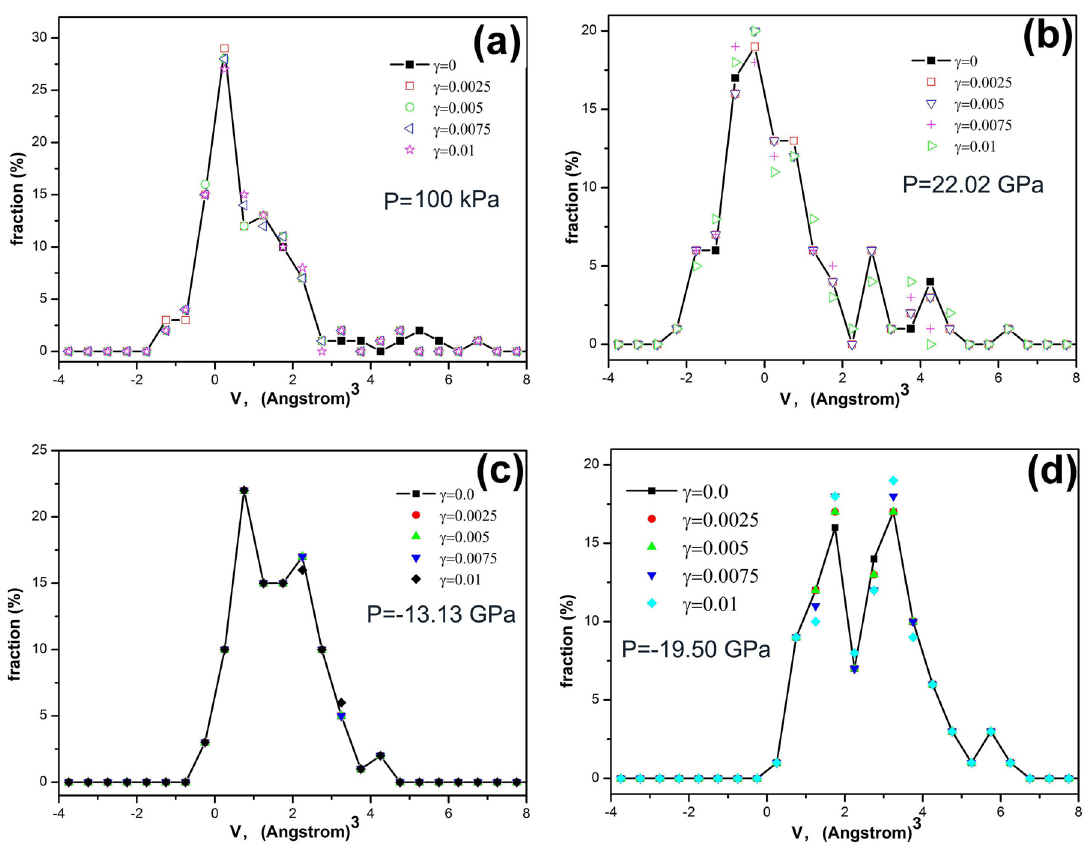
Figure 3. ( a – d ) Histograms of excess volumes v in Fe-Si-B glassy alloys at different hydrostatic pressures P and under various elastic shear